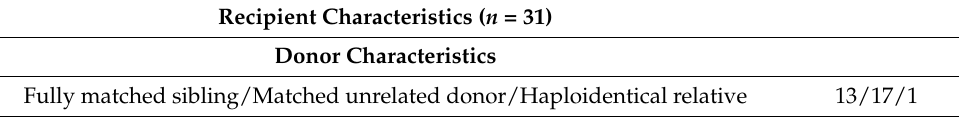
Table 1. Cont . Table 2. The effects of PMA stimulation on circulating CD3 + CD4 + T cells, CD3 + CD8 + T cells and CD3 − mononuclear cells derived from allotransplant recipients on day +90 post-transplant. Cells were stimulated either with PMA alone or with PMA combined with anti-CD3 + anti-CD28, and the effect of these stimulations on the phosphorylation of AKT/mTOR/STAT3 was evaluated by flow cytom- etry. All p -values refer to a statistical comparison (i.e., increased phosphorylation) between cultures with an activation signal (PMA alone or PMA+anti-CD3 + anti-CD28) and the corresponding control cultures prepared in medium alone. All comparisons were carried out using the Wilcoxon signed- rank test and we only present stimulations with a p -value < 0.05.